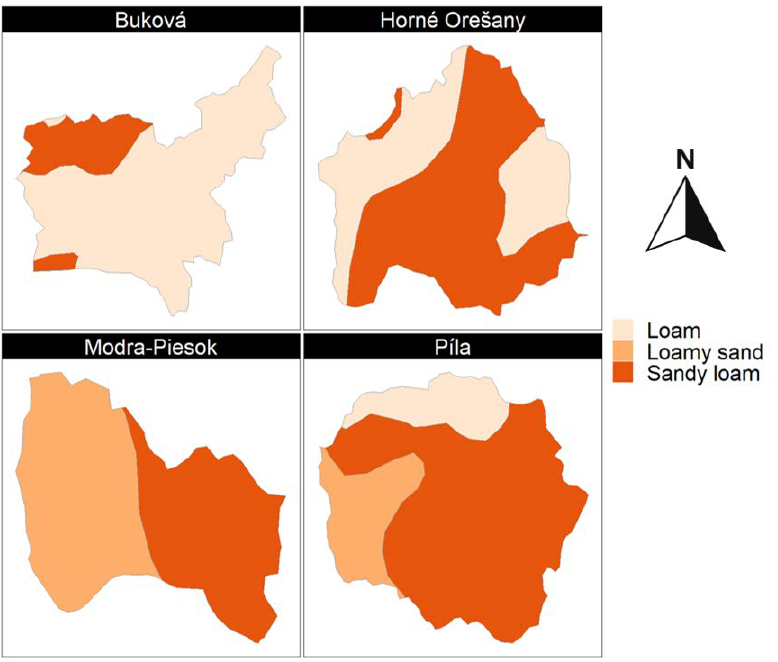
Figure 10. Maps of soil textural classes in